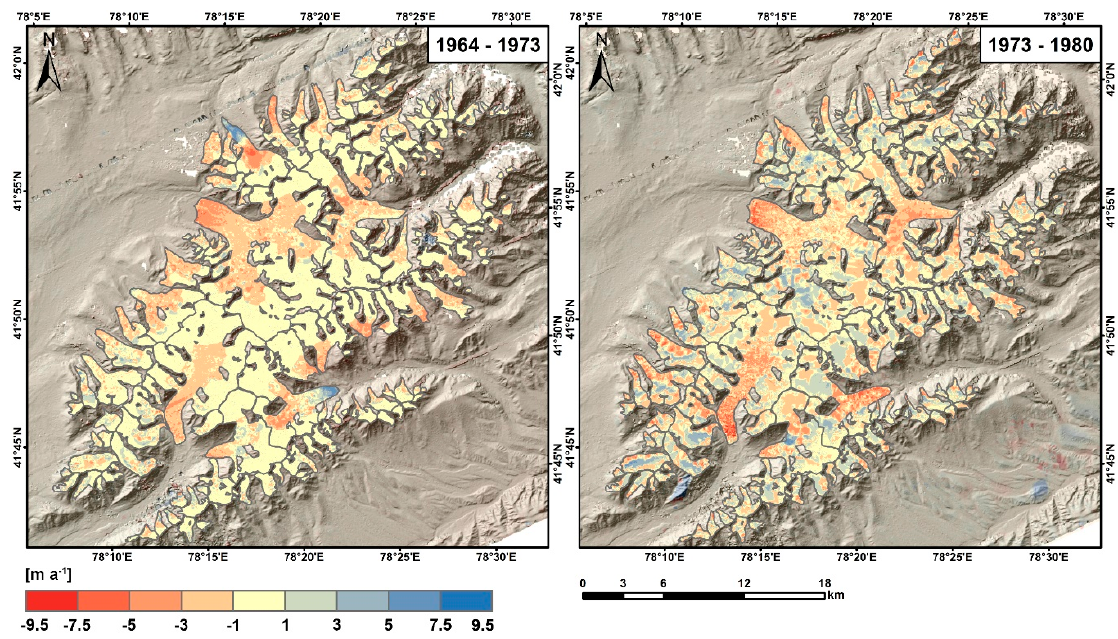
Figure 7. Glacier surface elevation differences for the entire Ak-Shirak range for the 1964–1973 and 1973–1980 periods.